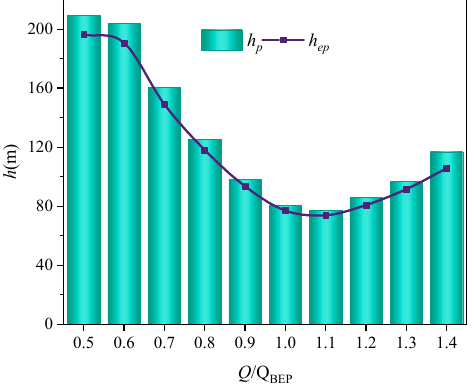
Figure 5. Hydraulic loss comparison between entropy production method and differential pressure method.